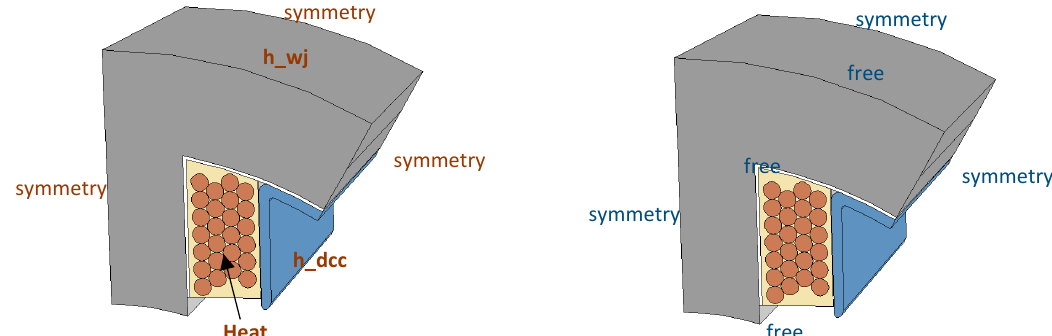
Figure 4. Boundary conditions for thermal ( left ) and mechanical simulations ( right ).